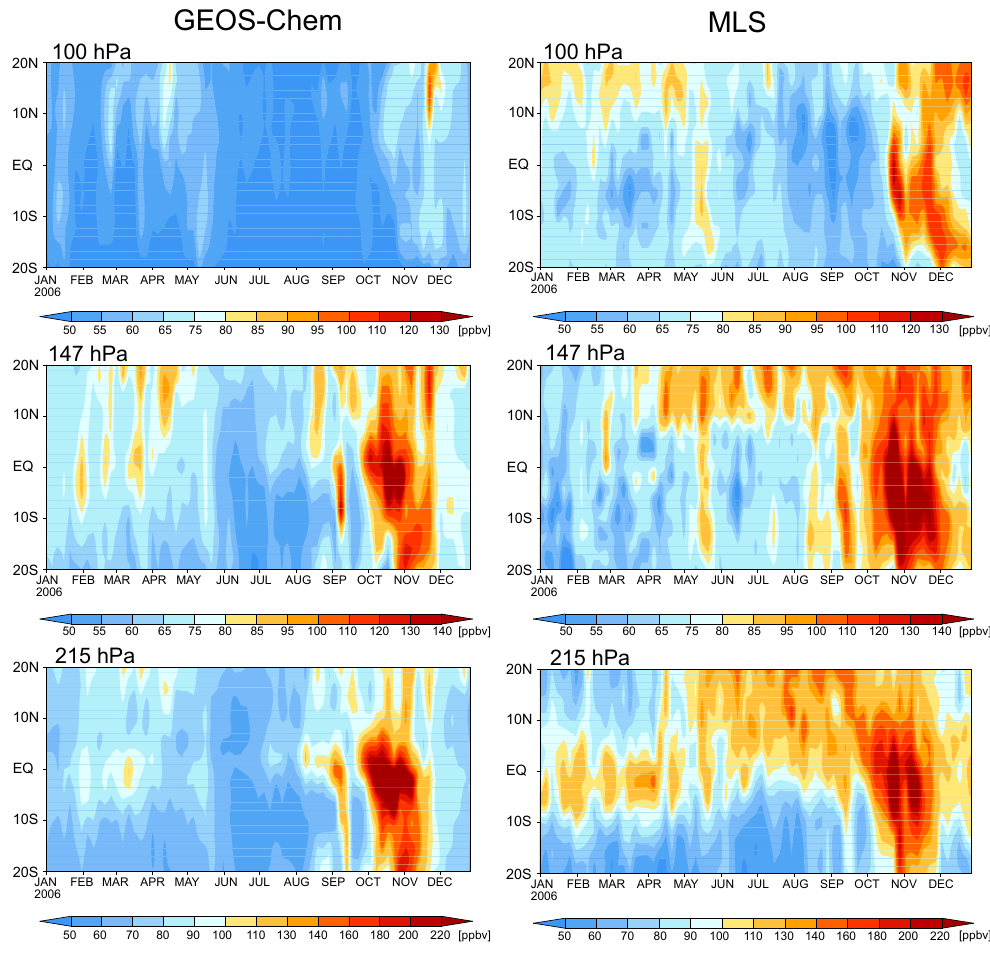
Fig. 6. Time-latitude cross-sections of GEOS-Chem simulated and MLS retrieved CO concentrations at 100hPa (top panels), 147hPa (middle panels) and 215hPa (bottom panels) for 2006. Values are averages over the 100 ◦ E–125 ◦ E